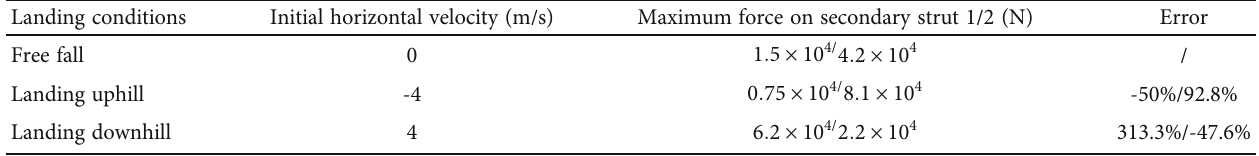
Table 6: Impact of initial horizontal velocity on the maximum force on secondary strut.